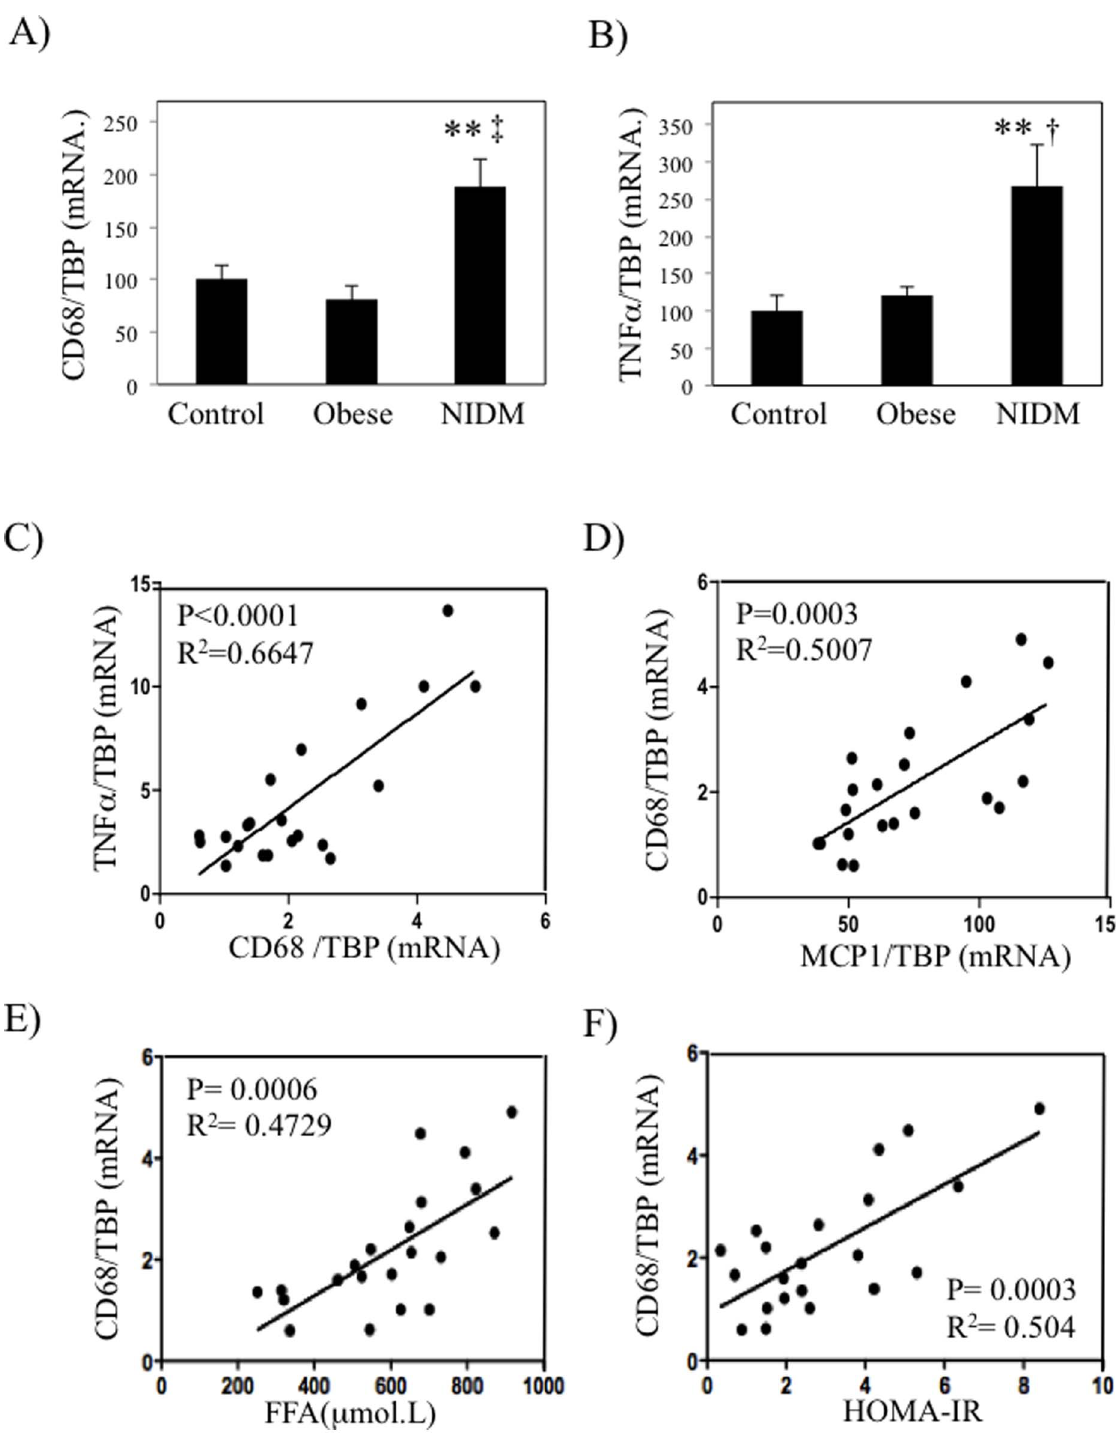
Figure 7. Inflammation markers are increased in skeletal muscles of type 2 diabetic patients and correlate with HOMA-IR. Biopsies from vastus lateralis of control subjects (n=8), obese non-diabetic patients (n=9) and obese type 2 diabetic patients (NIDM, Non Insulin-dependent Diabetes Mellitus) (n=10) were collected and qPCR were performed for CD68 (A) and TNF a (B). Correlation analyses between the expression of CD68 and TNF a (C) and MCP1 and CD68 in the vastus lateralis of patients (D). E–F) Correlation analyses between plasma FFA and HOMA-IR levels of subjects and CD68 expression, respectively. ** stands for P , 0.01 when comparing NIDM group with Control, { stands for P , 0.05 and ` for P , 0.01 when comparing NIDM with Obese.